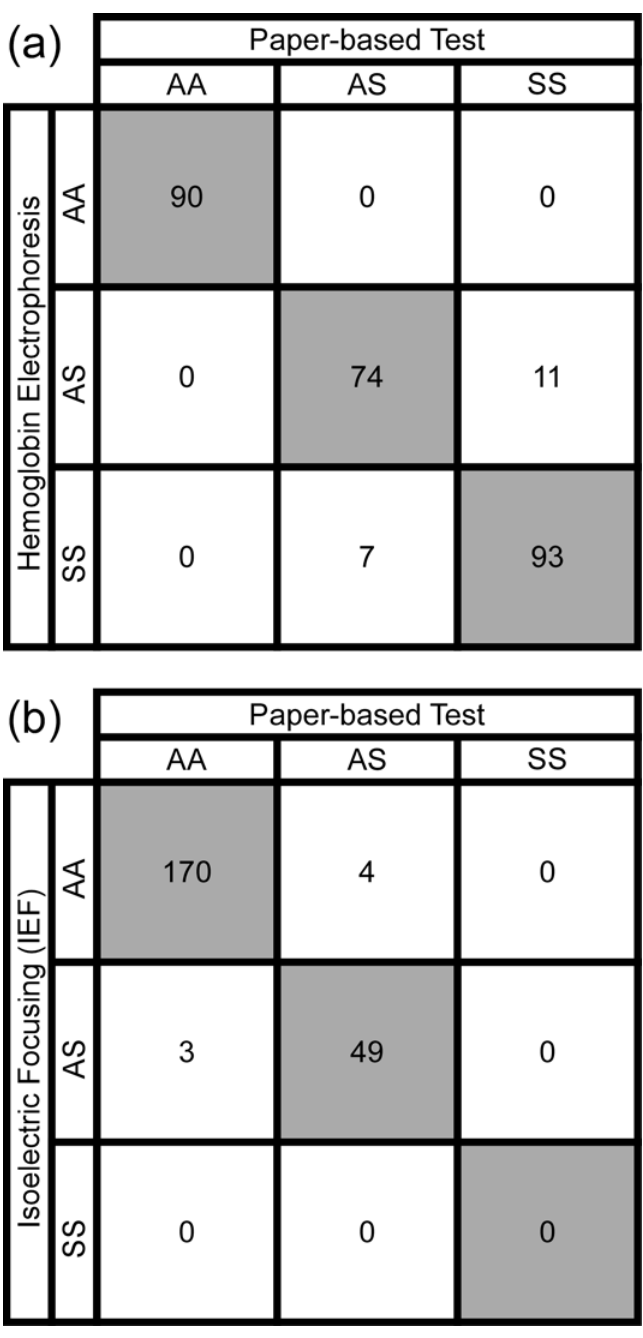
Fig 2. Validation of the paper-based SCA test in a research laboratory and in a resource-limited clinical setting (Cabinda, Angola). ( a ) Aggregate confusion matrix for the diagnoses of blood samples collected from normal volunteers and patients of Pediatric Hematology-Oncology Clinic at Tulane University Hospital and of the Sickle Cell Center of Southern Louisiana (New Orleans, LA) performed via visual evaluation of the blood stains by human scorers (n = 5). Rows correspond to true genotypes (diagnosed by hemoglobin electrophoresis) and columns correspond to predicted genotypes (diagnosed by the paper- based test). Shaded cells along the diagonal contain numbers of correct diagnoses. ( b ) Confusion matrix for the diagnoses of blood samples collected at the Primero de Maio obstetric hospital from postnatal females with unknown SCA status. The rapid test was performed and interpreted via visual evaluation by healthcare workers at the newborn screening laboratory of the Clinica de Celulas Falciformes at the